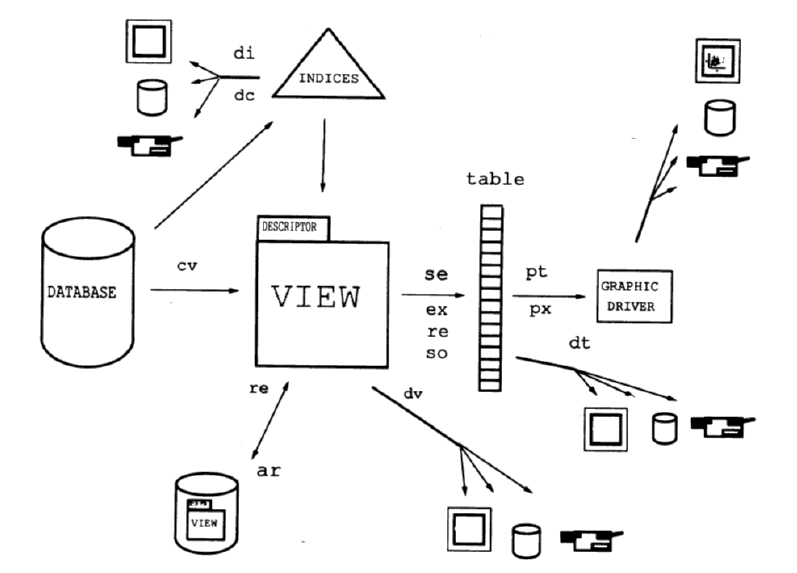
Figure 3. TOPbase functional blueprint showing: the two main data structures, the view and the table ; the display, printing, and graphic capabilities; and the query commands of the original command-based version. Reproduced from Figure 2 of